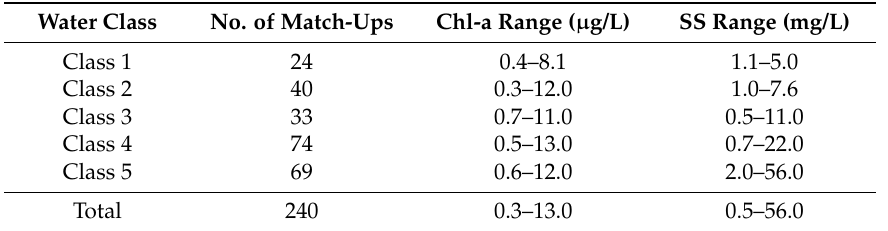
Table 2. Distribution of satellite and in situ data match-ups for cloud-free scenes over study area